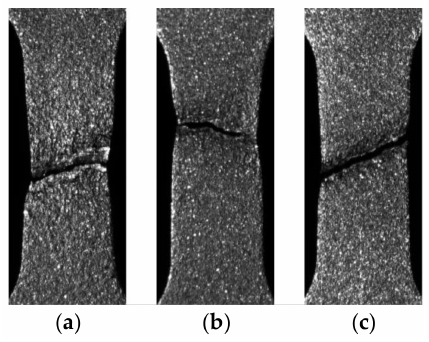
Figure 10. Images of specimens after rupture for strain rates: ( a ) 10 − 3 s − 1 ; ( b ) 10 − 2 s − 1 ; and ( c ) 10 − 1 s − 1